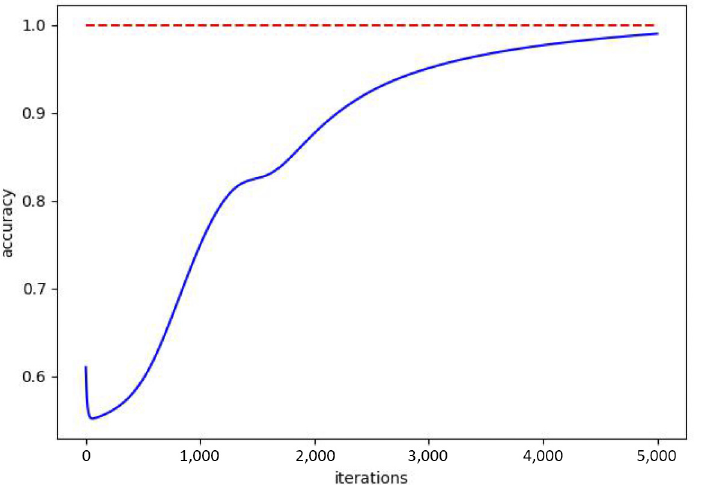
Figure 12. Accuracy of global model with